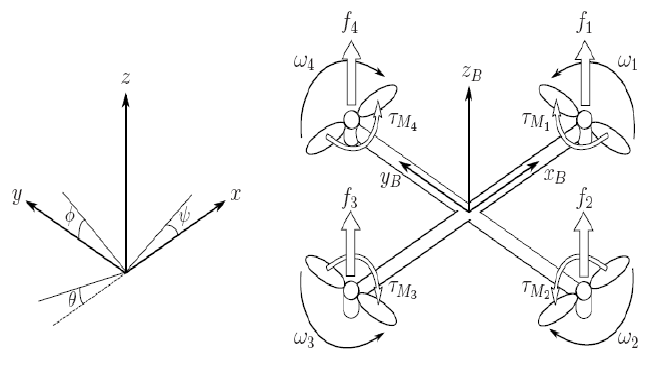
Figure 1. Quadcopter